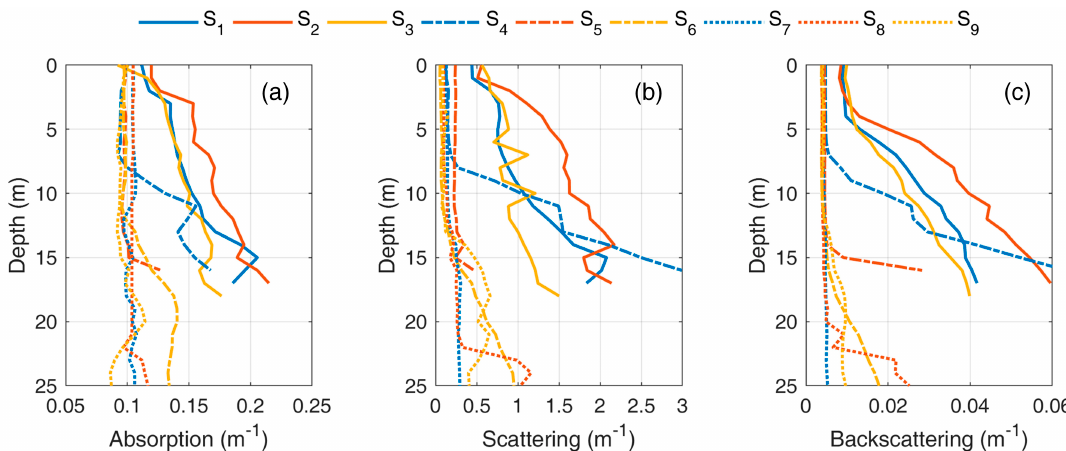
Figure 5. The in situ data collected in the Yellow Sea, including ( a ) the absorption coefficient, ( b ) the scattering coefficient and ( c ) the backscattering coefficient.